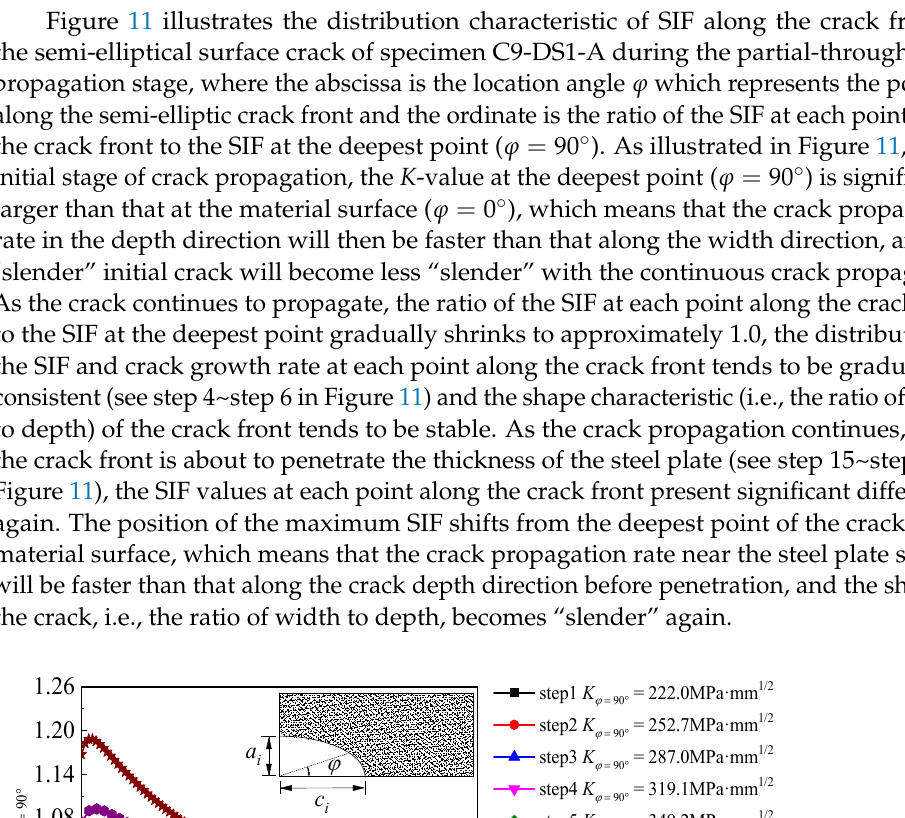
Figure 12. Distribution of tensile stress along the crack front of specimen C9 ‐ DS1 ‐ A during through crack propagation stage (unit: MPa): ( a ) step 22, ( b ) step 24, ( c ) step 26, and ( d ) step 28.